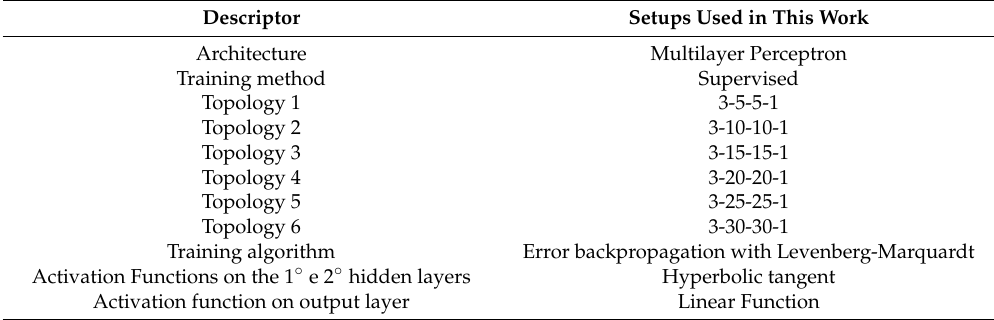
Table 7. Setup of the artificial neural networks (ANNs)